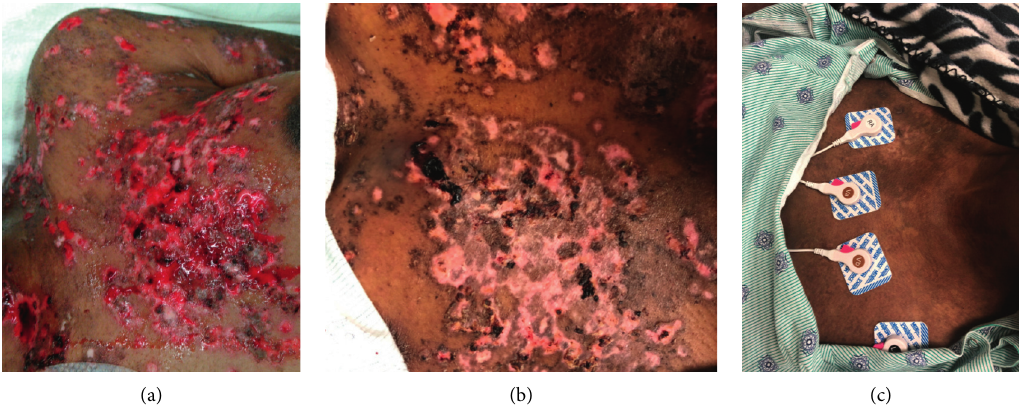
Figure 3: Left anterior chest wall demonstrating full-thickness epidermal necrosis with large areas of bleeding, denuded skin. Center image shows healing two weeks posttreatment and the image on the left shows complete resolution at 3 months since induction with